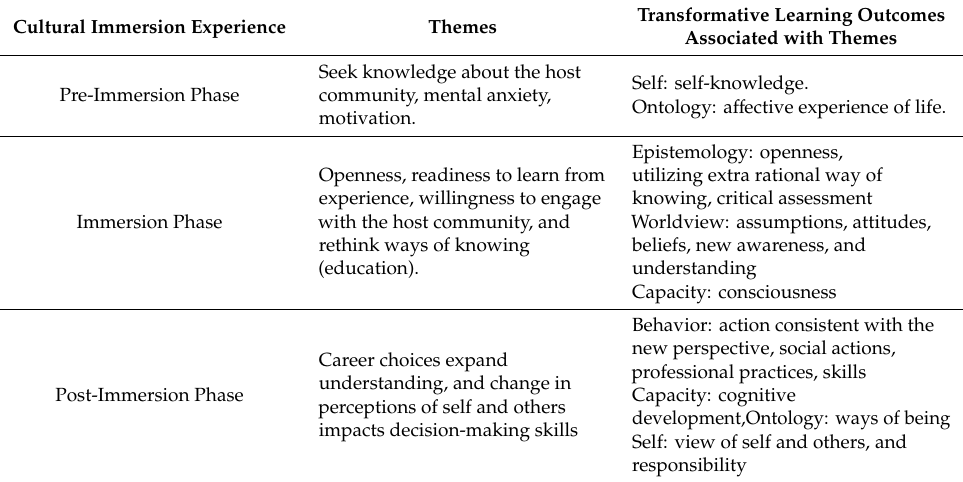
Table 1. Summary of transformative learning outcomes